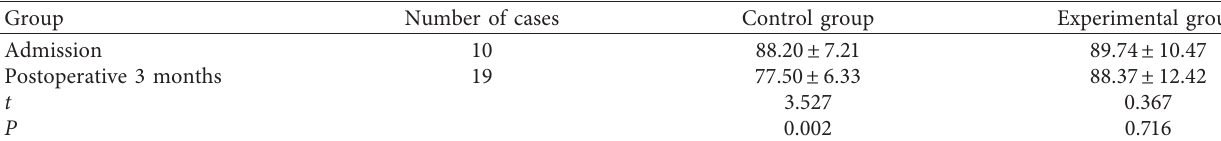
Table 5: Comparison of quality of life scores of patients in the same group (SF-36).